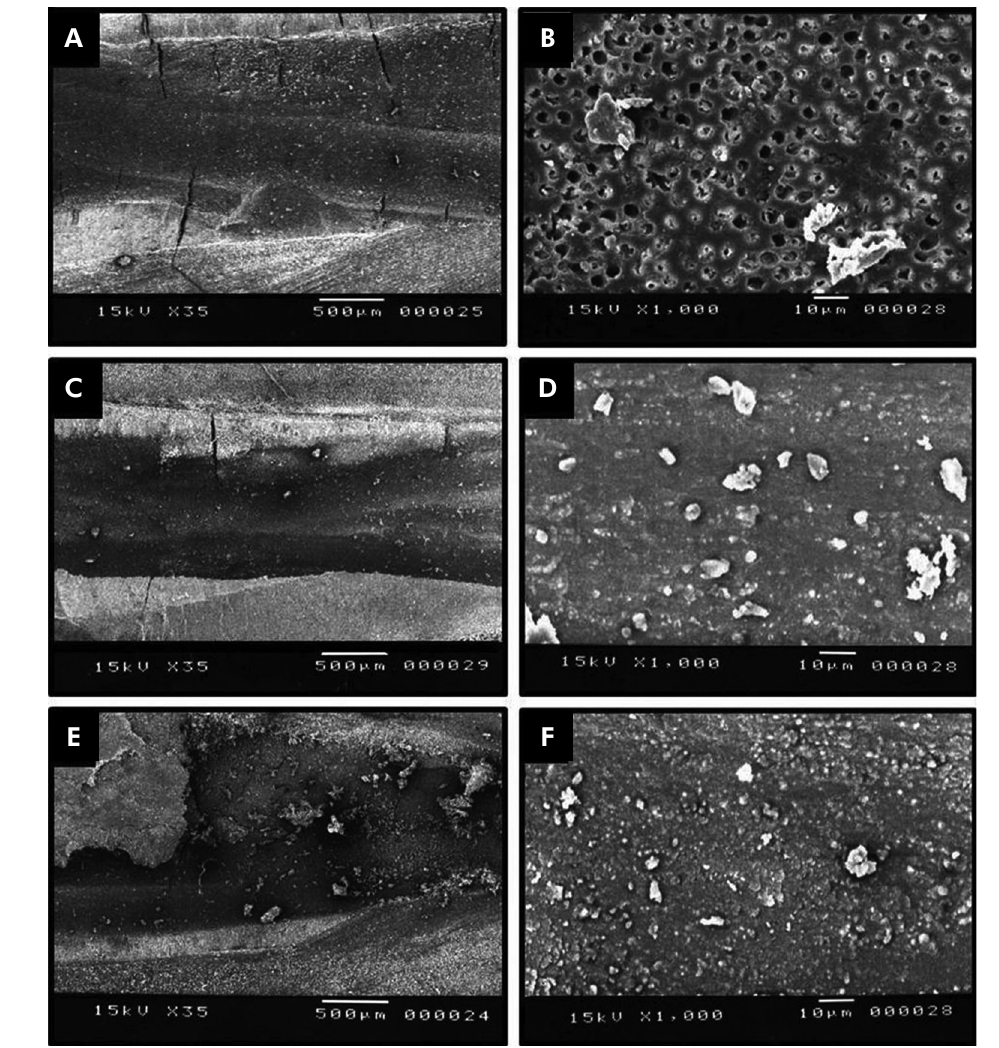
Figure 2. Representative SEM photomicrographs of the conventional irrigation/aspiration + brush protocol. A) Cervical third with the wall covered by debris (35×); B) Cervical third with the smear layer and dentinal tubules partially obliterated (1,000×); C) Middle third with the debris covering > 50% of the surface (35×); D) Middle third with the smear layer and dentinal tubules totally obliterated (1,000×); E) Apical third with the debris clusters within the canal (35×); F) Apical third with the smear layer and dentinal tubules completely covered